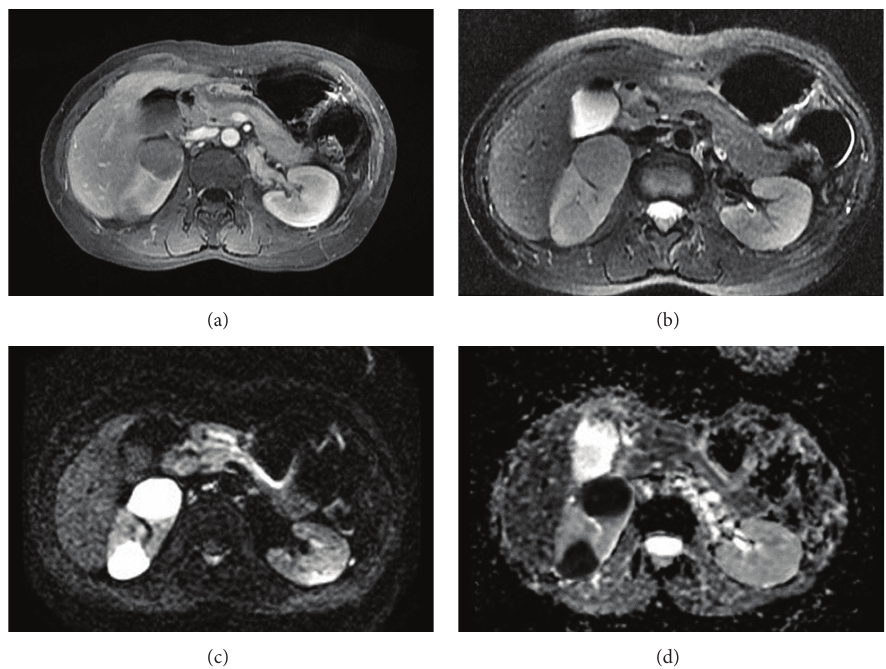
Figure 2: Abdominal magnetic resonance imaging (MRI). Abdominal MRI showed right kidney multiple lesions without enhancement during arterial phase of dynamic study (a), hypointense masses on T2-weighted images (b), and multifocal hypovascular hypercellular solid tumors of the right kidneys with bright lesion in diffusion weighted imaging (DWI) (c) and significantly decreased apparent diffusion coefficient (ADC)